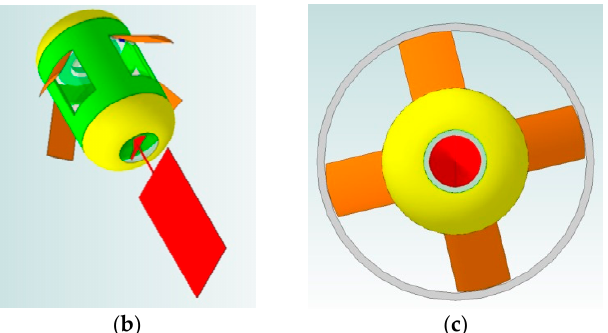
Figure 3. ( a ) Magnetically actuated capsule microrobot with leg close, ( b ) Magnetically actuated capsule microrobot with leg open, ( c ) Stop motion by the open leg in pipe.